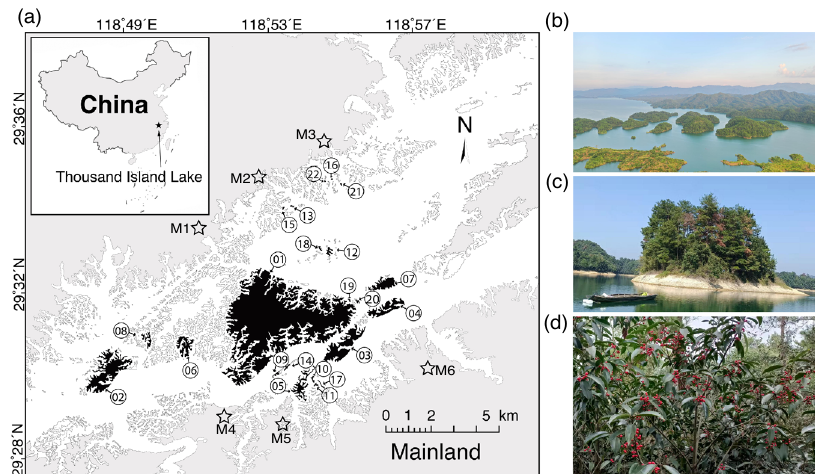
Fig. 1 Map of the study region and the fragmented landscape of the study system. The 22 study islands (in black) and six surrounding mainland sites (in pentacle, where ‘ M ’ indicates ‘ Mainland site ’ ) in the Thousand Island Lake, Zhejiang, China (the map in panel a modi fi ed from Si et al. 54 ). Islands are labelled by decreasing area, from 01 = largest to 22 = smallest. All unsurveyed islands and the mainland are shown in light grey, with water in white. b – d show the landscape of the lake, a reservoir island, and a common fruiting plant ( Ilex chinensis ).